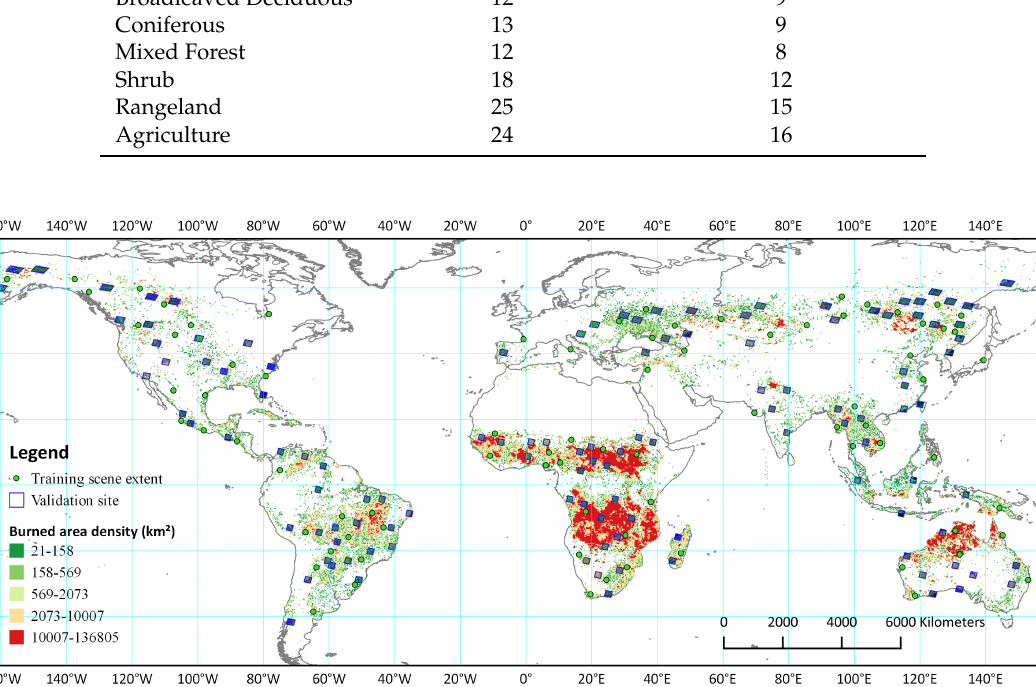
Figure 1. The distribution of 120 random Landsat image scenes and 80 validation sites over a map of BA density extracted from GFED4